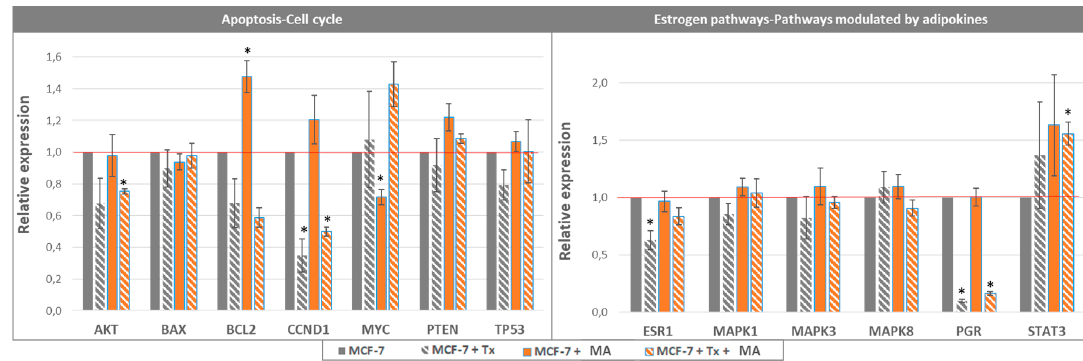
Figure 4. Relative gene expression in MCF-7 cells co-cultured with mature adipocytes and treated with tamoxifen ( n = 3, * p < 0.05).